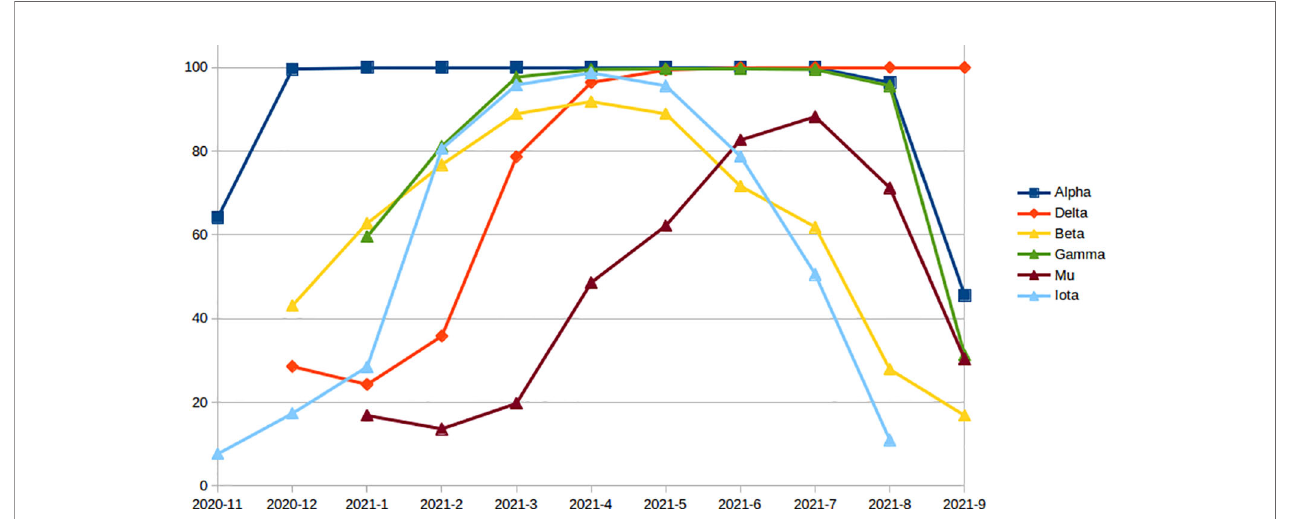
FIGURE 3 | Monthly percentage of epitopes with PEM in different variants since the fi rst reporting